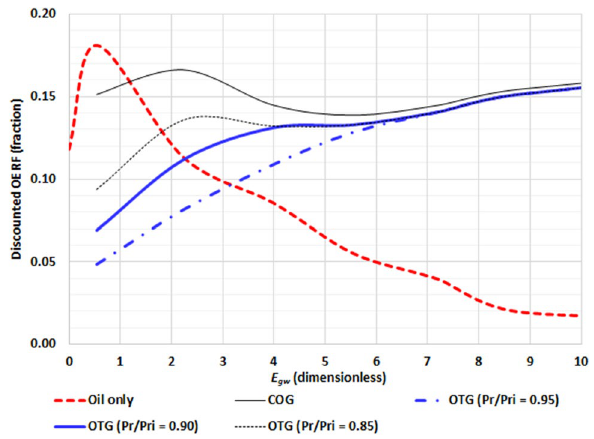
Fig. 9 Discounted OE RF versus E zontal oil producers. Note that E gw = 0 refers to the undersaturated